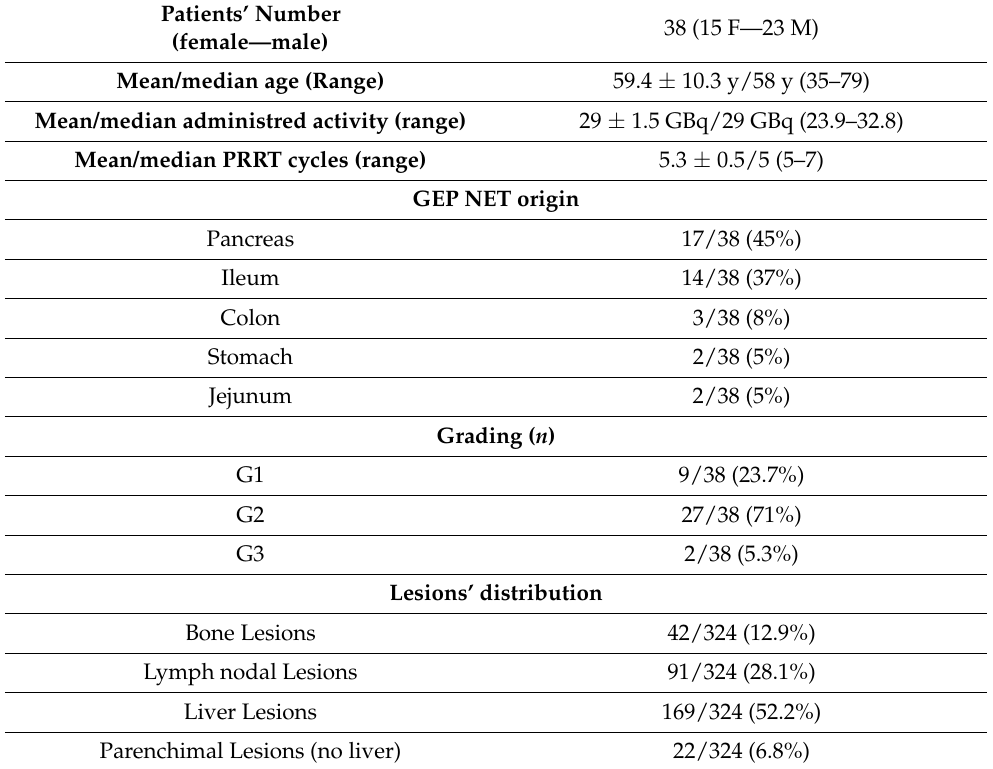
Table 1. Patients’ main